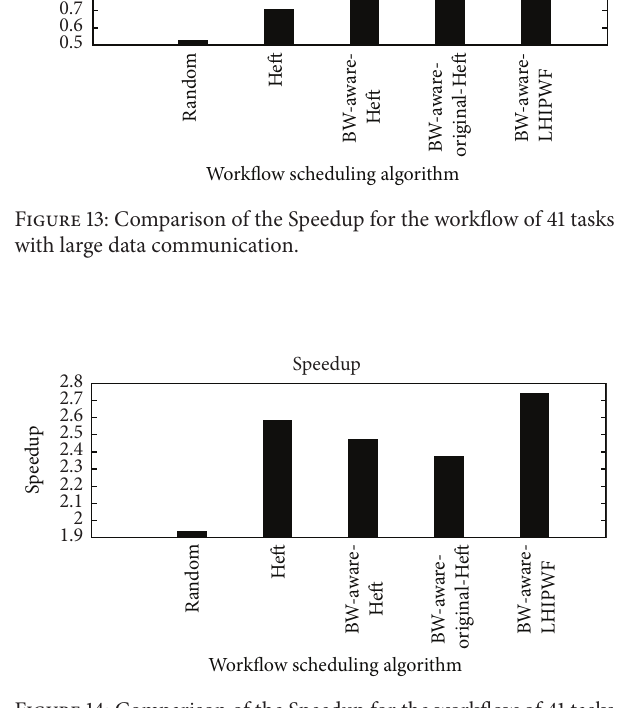
Figure 14: Comparison of the Speedup for the workflow of 41 tasks with small data